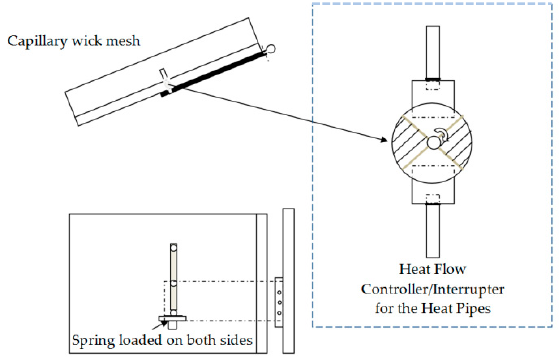
Figure 10. Heat Pipe Controls of the PVT-3.